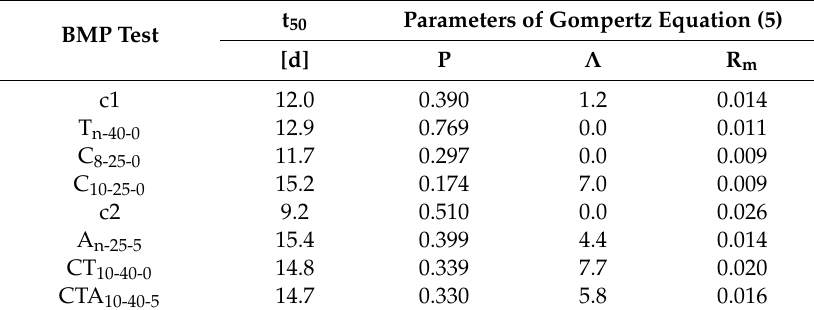
Table 5. Kinetic parameters of the Gompertz modified Equation (5).